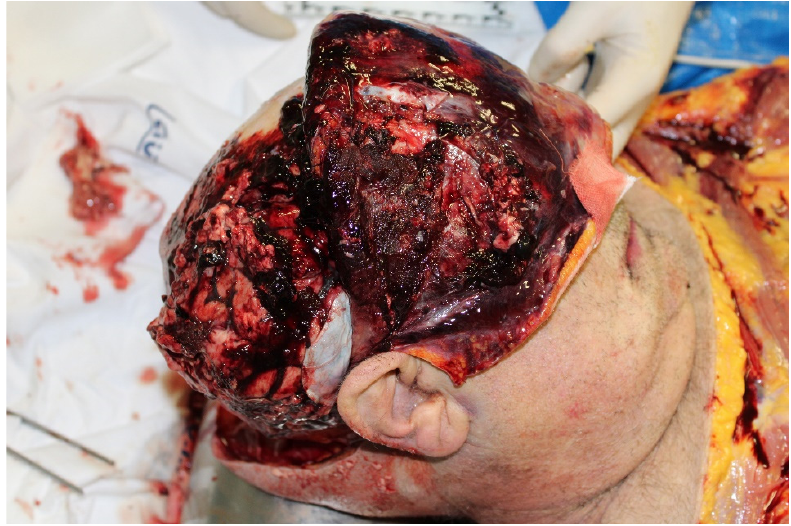
Figure 4. Cerebral hemorrhage in case 2.